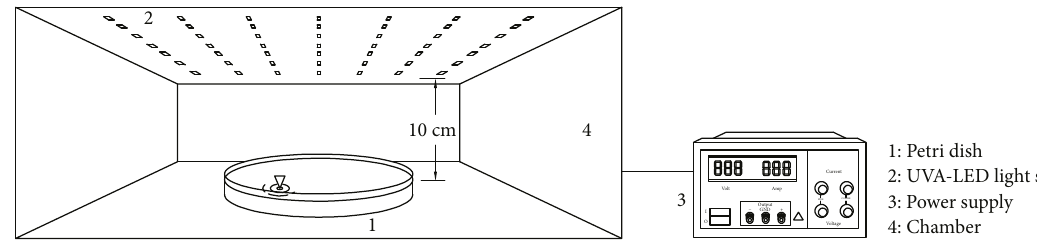
Figure 2: The schematic of the photocatalytic bacterial inactivation